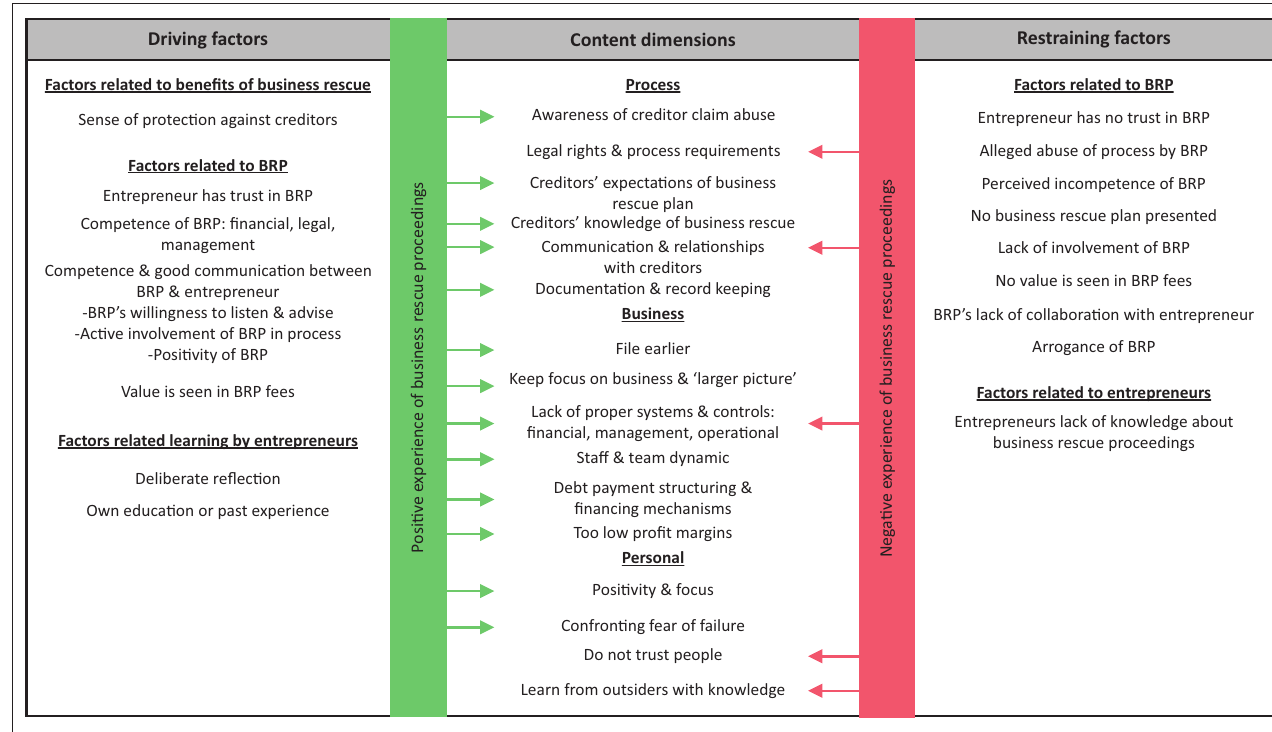
FIGURE 1: Conceptual framework of entrepreneurial learning from business rescue proceedings in South